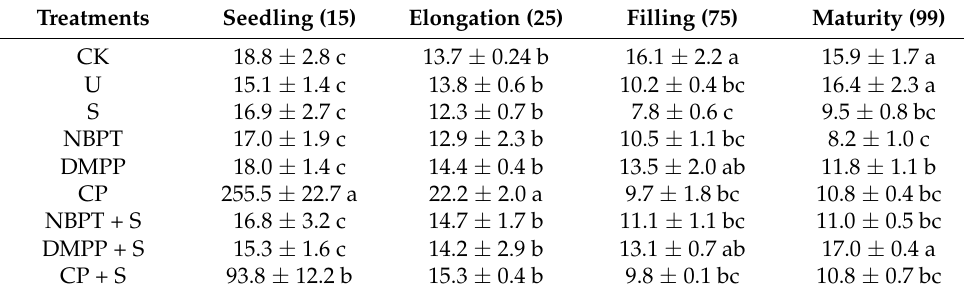
Table 2. Contents of NH 4+ -N of different treatments in soil (mg kg − 1 ).